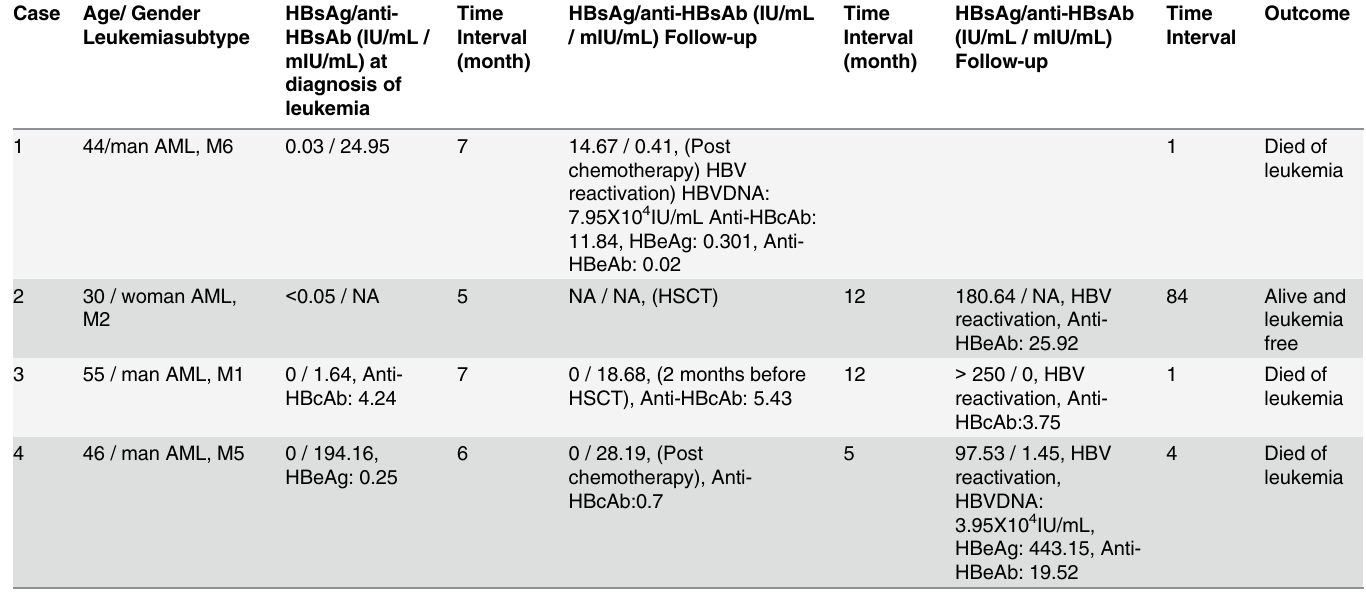
Table 4. The clinical course of four hepatitis B surface antigen negative AML patients who experienced hepatitis B reactivations despite lack of ev- idence of chronic HBV carriage. Case Age/ Gender